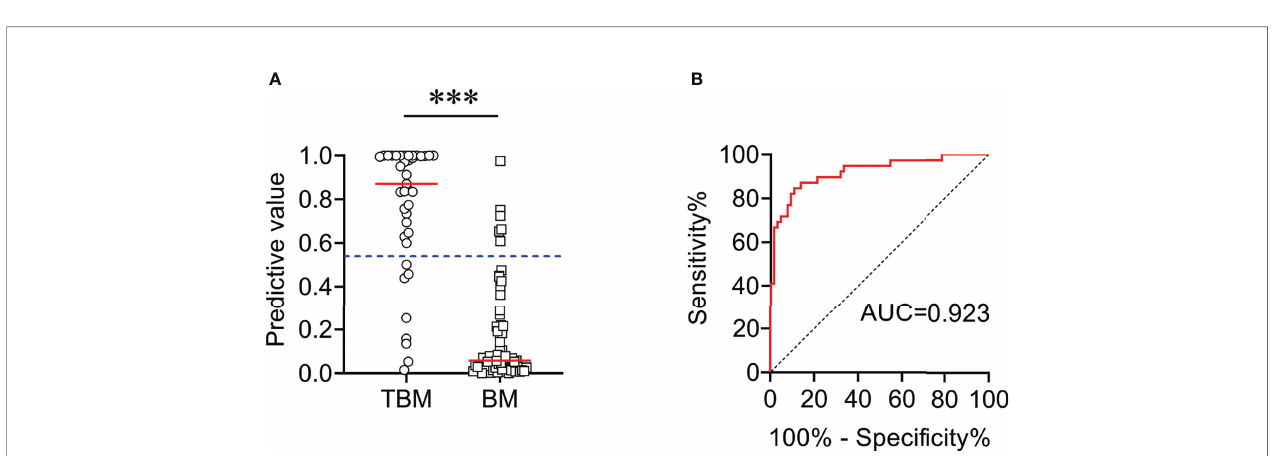
FIGURE 7 | The performance of diagnostic model for discriminating TBM from BM in Caidian cohort. (A) Scatter plots showing the predictive value of the diagnostic model in TBM patients (n = 39) and BM patients (n = 66). Horizontal lines indicate the medians. *** P < 0.001 (Mann – Whitney U test). Blue dotted lines indicate the cutoff value in distinguishing these two groups. (B) ROC curve analysis showing the performance of the diagnostic model in distinguishing TBM from BM. ROC, receiver operating characteristic; AUC, area under the ROC